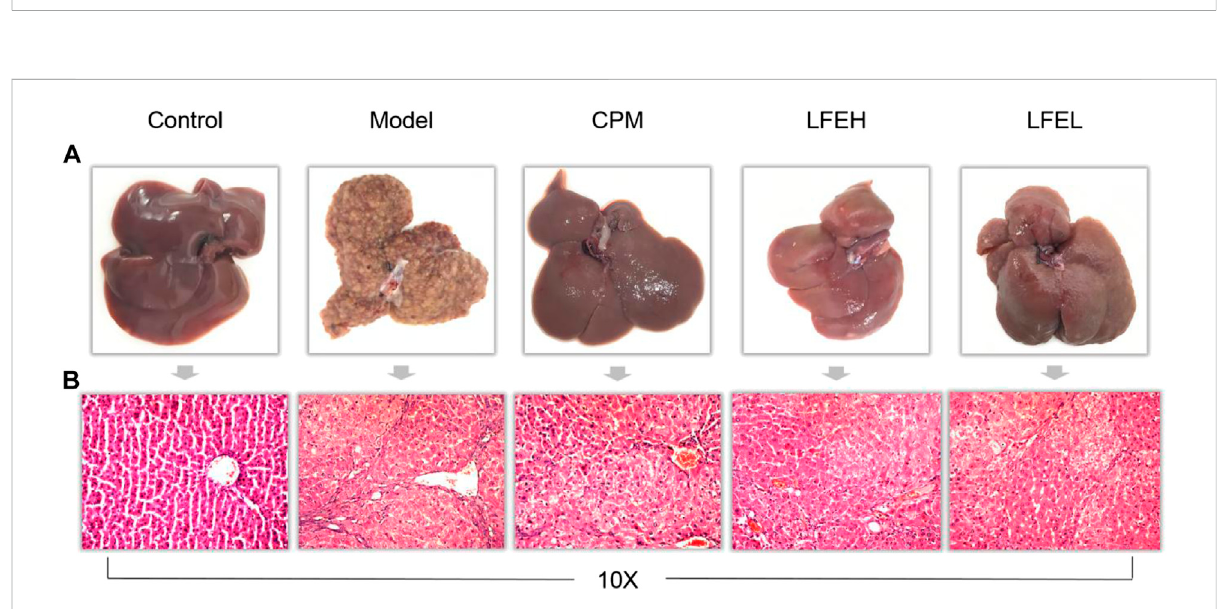
FIGURE 3 ImpactofLFEonpathologicalindexesoflivertissueinratswithHCC. (A) Liverappearanceofratsineachgroup. (B) Liverhistopathologyofratsineach group. Control, the blank group; Model, the model group; CPM, the cyclophosphamide group; LFEH, LFE high-dose group; LFEL, LFE low-dose